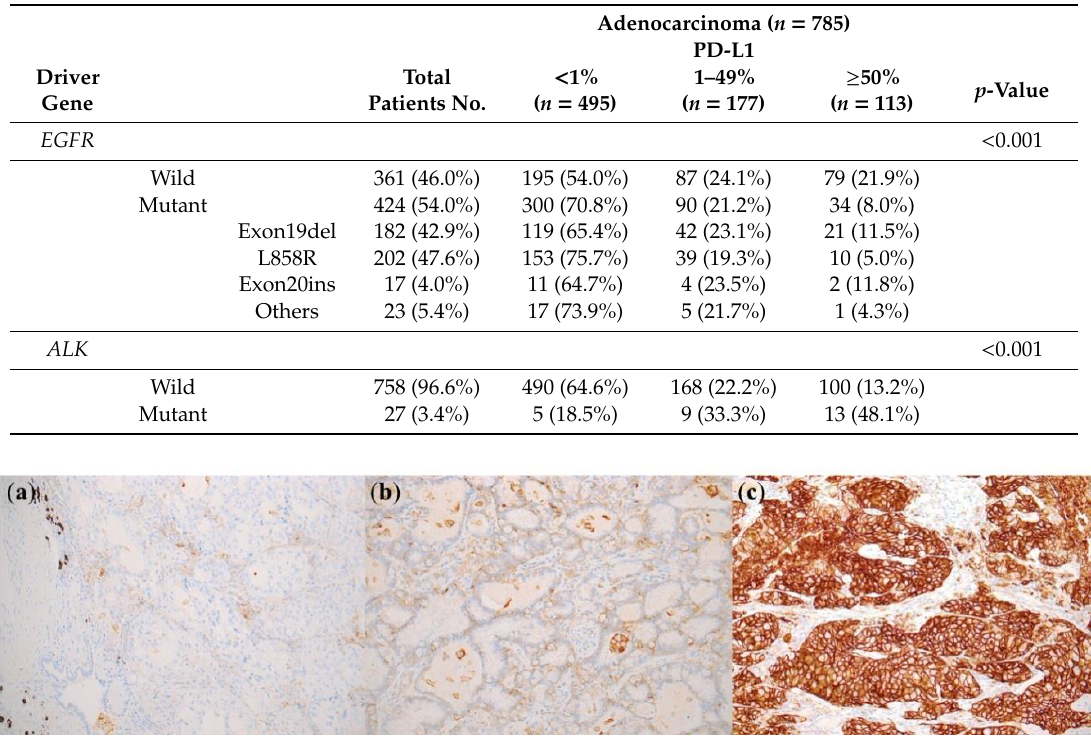
Table 3. Association between PD-L1 expression and driver genetic status in lung adenocarcinoma.